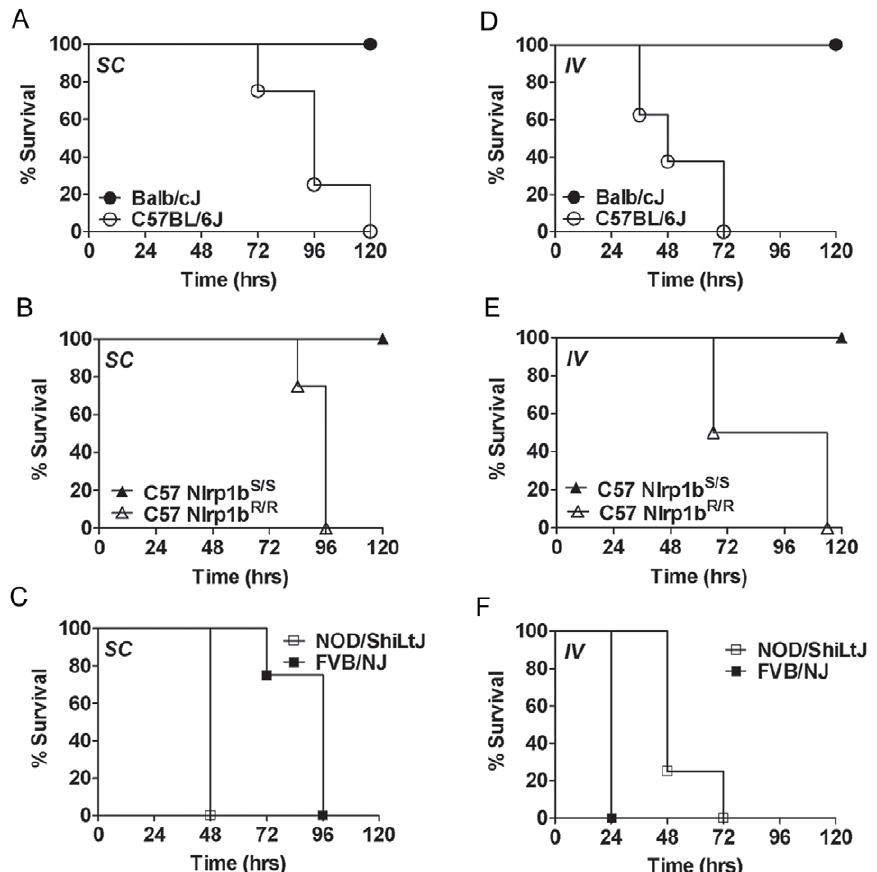
Figure 4. Susceptibility to infection with vegetative bacteria. Complement-sufficient Balb/cJ and C57BL/6J mice (panels A, D) or C57BL/6NTac Nlrp1b S/S and C57BL/6NTac Nlrp1b R/R mice (panels B, E) were challenged (1 6 10 5 vegetative bacteria, 200 m l, SC (A, B) or IV (D, E)) and monitored for survival. Complement-deficient NOD/ShiLtJ and FVB/NJ mice were challenged with 1 6 10 4 vegetative bacteria SC (C) or IV (F) and monitored. Open symbols denote mice harboring Nlrp1b S and closed circles are used for mice harboring Nlrp1b S . P-values for the comparison of the two curves in each panel are , 0.01.